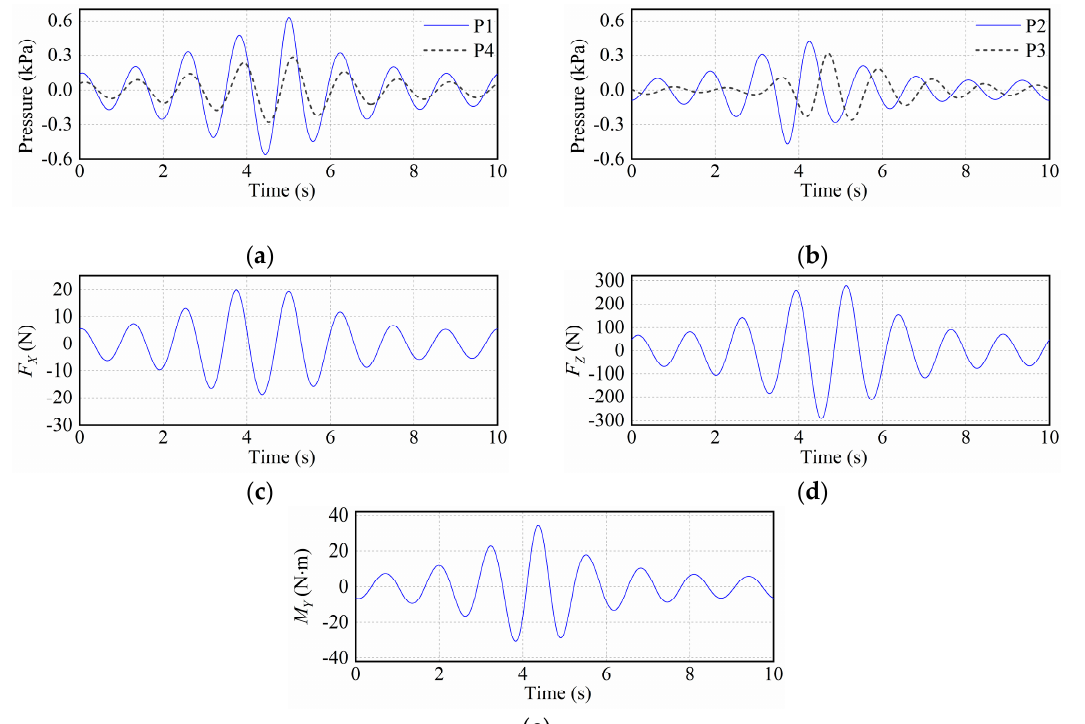
Figure 6. Typical time series of ( a , b ) hydrodynamic pressure and ( c–e ) wave forces: k P d = 1.12, A max / d = 0.25, d 1 / d = 0.25, h / d = 0.1, B / d = 2. ( a ) Pressure at location P1 and P4; ( b ) Pressure at location P2 and P3; ( c ) Horizontal wave force; ( d ) Vertical wave force; ( e ) Overturning moment.